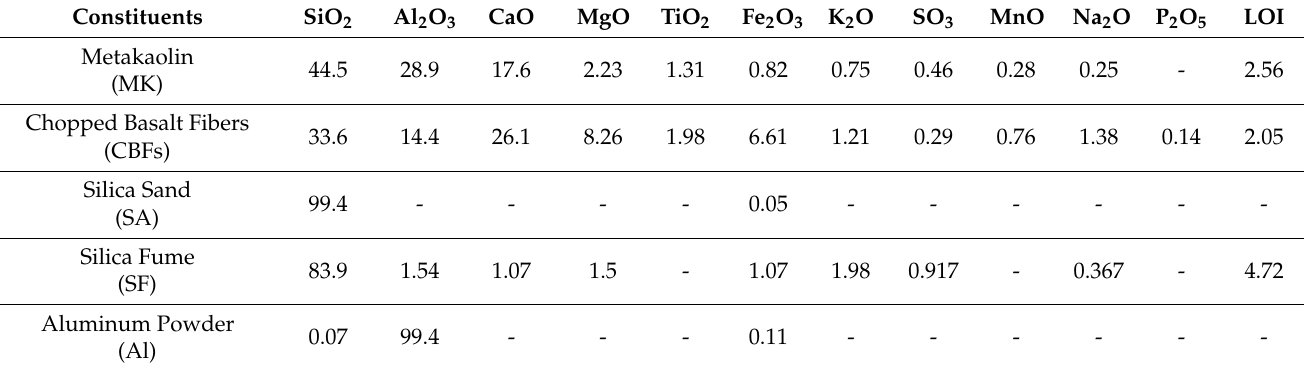
Table 1. Chemical compositions of main constituents of the GFs (wt.%).